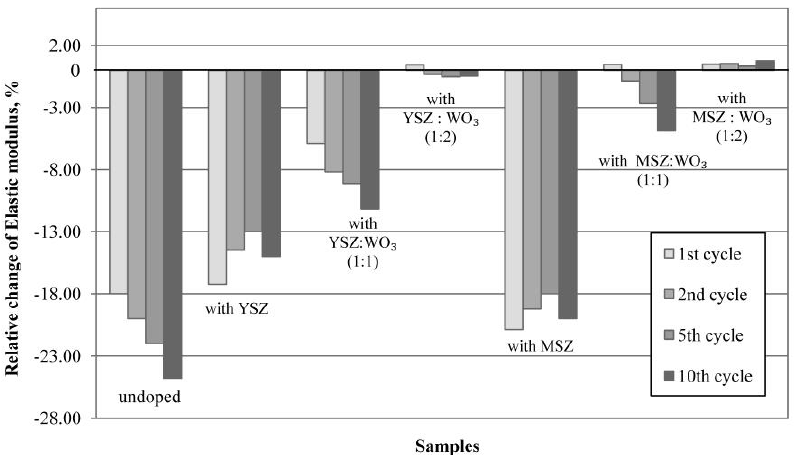
Figure 12. Relative change in the elastic modulus of samples after the thermal shock tests.